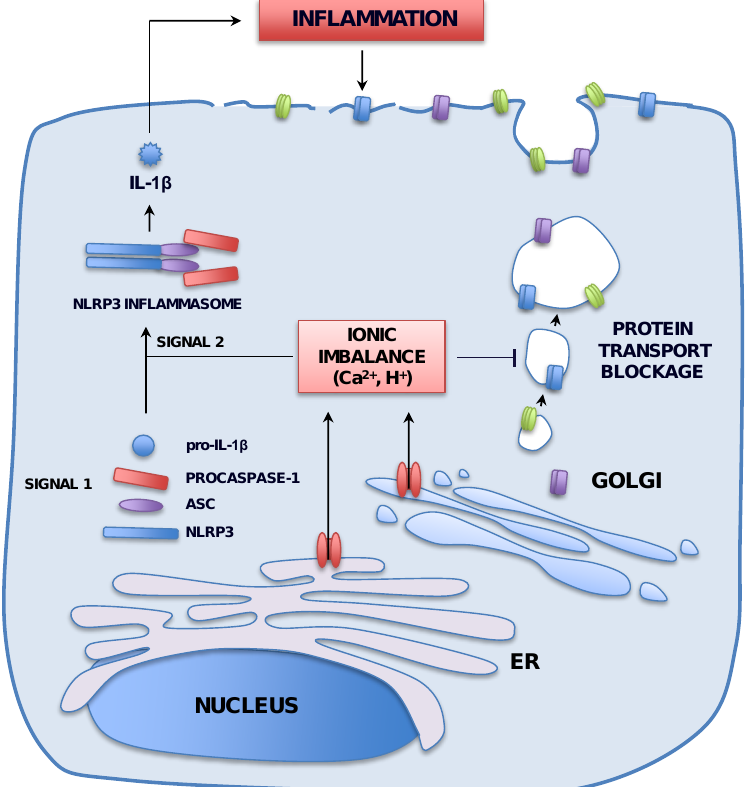
Figure 4. Pathways stimulated by viroporin ion channel activity leading to pathology. Molecular patterns associated with viral infections are recognized by cellular sensors (signal 1), which activate the transcription and translation of the NLRP3 inflammasome components (NLRP3, ASC and procaspase-1) and the inactive pro-IL-1 β . Viroporins inserted in the intracellular organelles, such as the endoplasmic reticulum (ER) or the Golgi apparatus, favor the leak of Ca 2 ` and H ` ions that move following their electrochemical gradient into cell cytoplasm. This ionic imbalance (signal 2) induces the assembly of the inflammasome complex, which triggers the maturation of pro-IL-1 β into IL-1 β through the action of caspase-1. Secreted IL-1 β mediates a potent pro-inflammatory response that can be deleterious for the cell and the organism, when overstimulated. In addition, alteration of ionic milieus in intracellular compartments comes along with a protein transport delay or blockage. This results in a decrease of the levels of MHC-I molecules (blue rectangles) at the plasma membrane, preventing the infected cell to be recognized by the immune system. Protein transport blockage also diminishes the levels and activity in the cell surface of ion channels and transporters, crucial in the resolution of edema accumulation. Epithelial sodium channels (green structure) and Na ` /K ` ATPase (purple rectangles) impairment have been related to the worsening of viral respiratory diseases such as those caused by SARS-CoV, IAV or